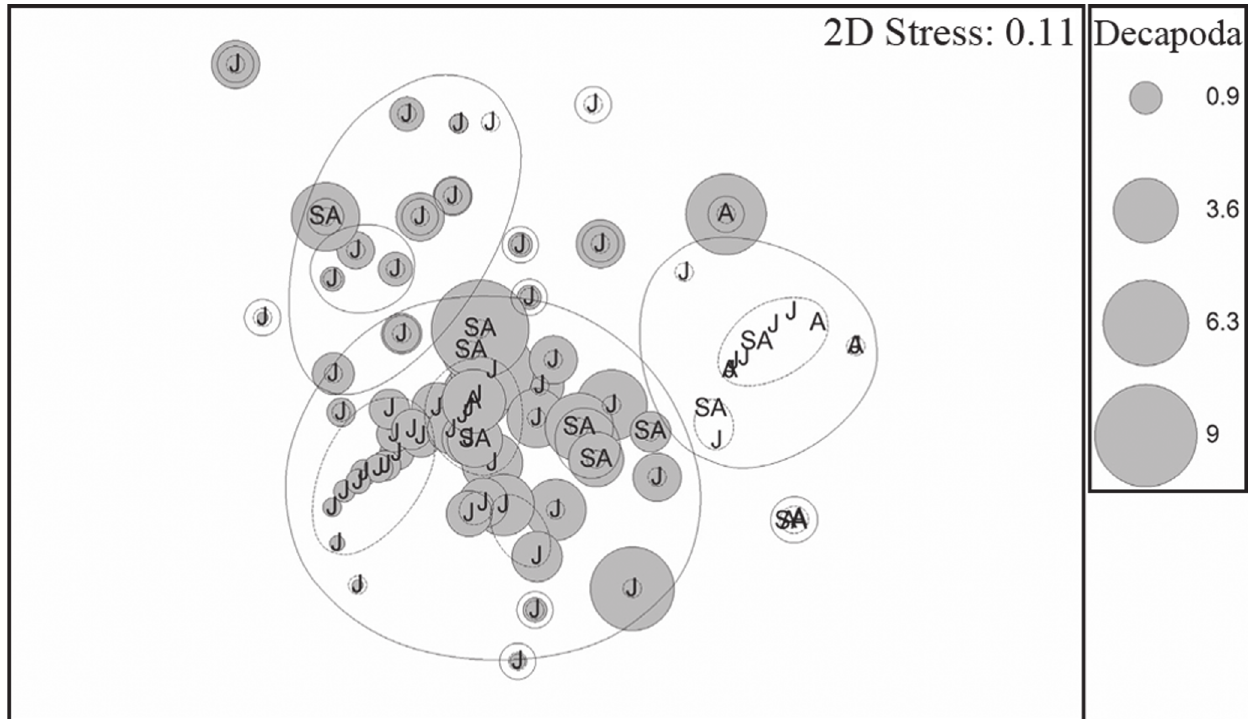
Fig. 2. Ordination resulting from nonmetric multidimensional scaling analyses (NMDS) with cluster overlay (volume prey) among sizes classes of Lutjanus analis from Abrolhos Bank coral reefs, Eastern Brazil, between June 2005 and March 2007.